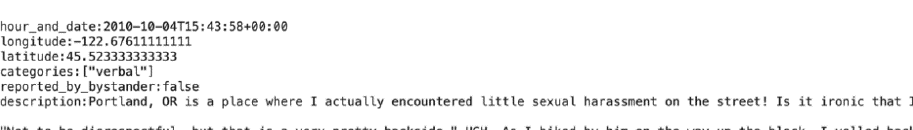
Figure 9. Workflow diagram of the harassment classification pipeline.